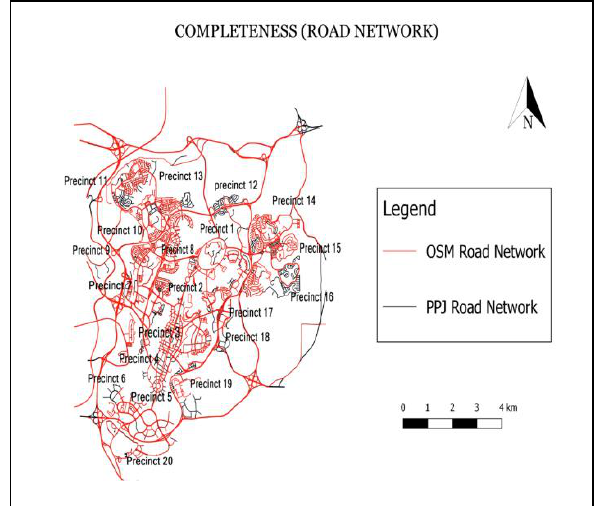
Figure 4: Completeness of road network